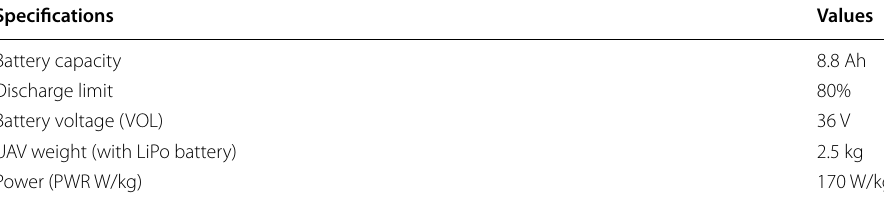
Table 2 UAV airtime calculation specifications